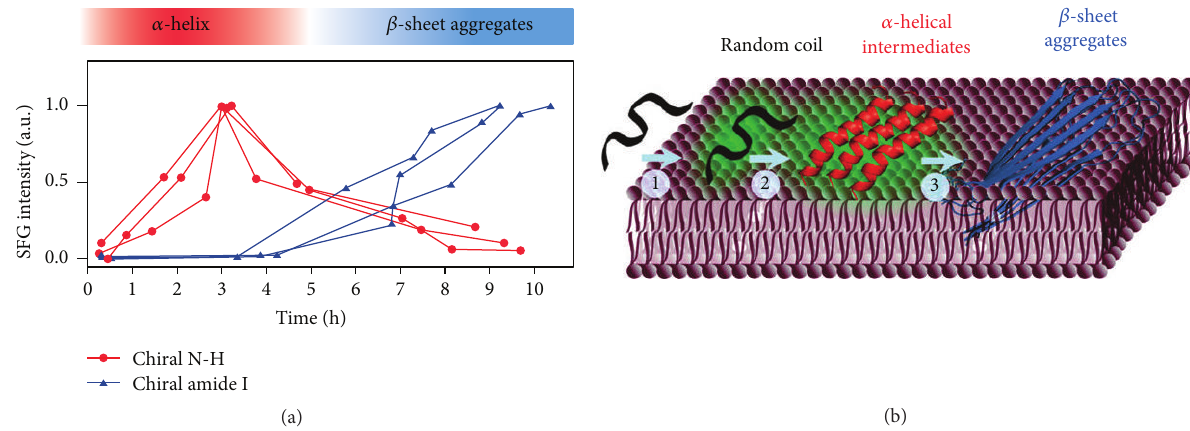
Figure 4: The misfolding pathway of hIAPP on membrane surfaces. (a) Chiral SFG intensities of the chiral N-H stretching (3280 cm −1 ) and amide I signals (1620 cm −1 ) as a function of time from triplicate experiments. (b) The model mechanism on hIAPP aggregation at the membrane surface: adsorption of disordered hIAPP onto membrane leads to formation of 𝛼 -helical intermediates which are then converted to 𝛽 -sheet aggregates. Adapted from [61] with permission. Copyright 2011 American Chemical